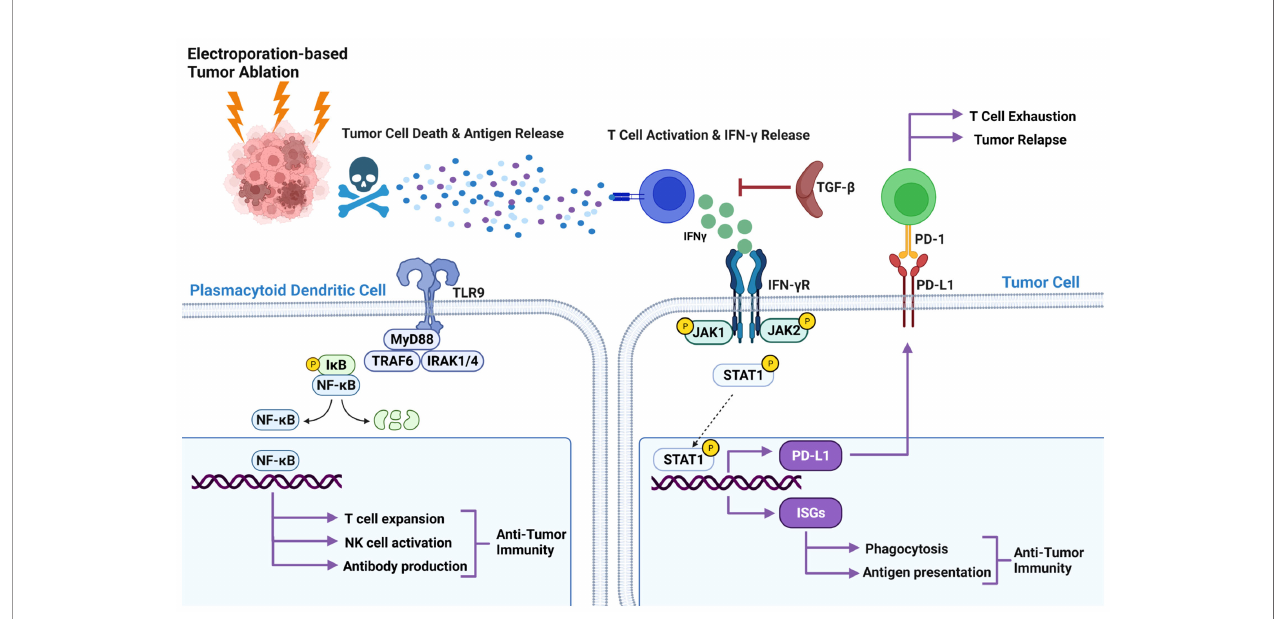
FIGURE 2 | Pathways involved in the IRE treatment of pancreatic cancer. Released antigen after IRE treatment activates CTL and induces IFN g expression. Binding IFN g to IFNR recruit and phosphorylate JAK1, and JAK2 activates STAT1 by phosphorylation results in translocation of STAT1 into the nucleus. In the nucleus STAT1 binds to the GAS site and starts the transcription of interferon-stimulated genes (ISGs). ISGs not only encode cytokines and chemokines, but also phagocytic receptors and antigen-presenting molecules. IFN g also induces PD-L1 expression by tumor cells through the JAK/STAT pathway. TLR9 agonists promote antitumor immunity through NK- k B